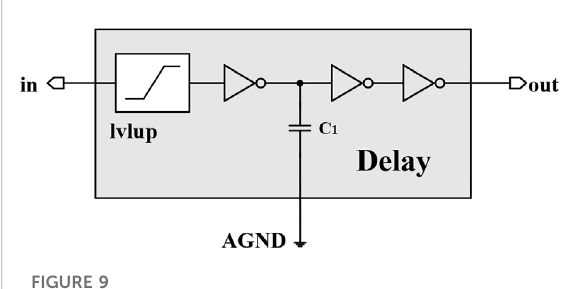
Schematic of the low-side predriver